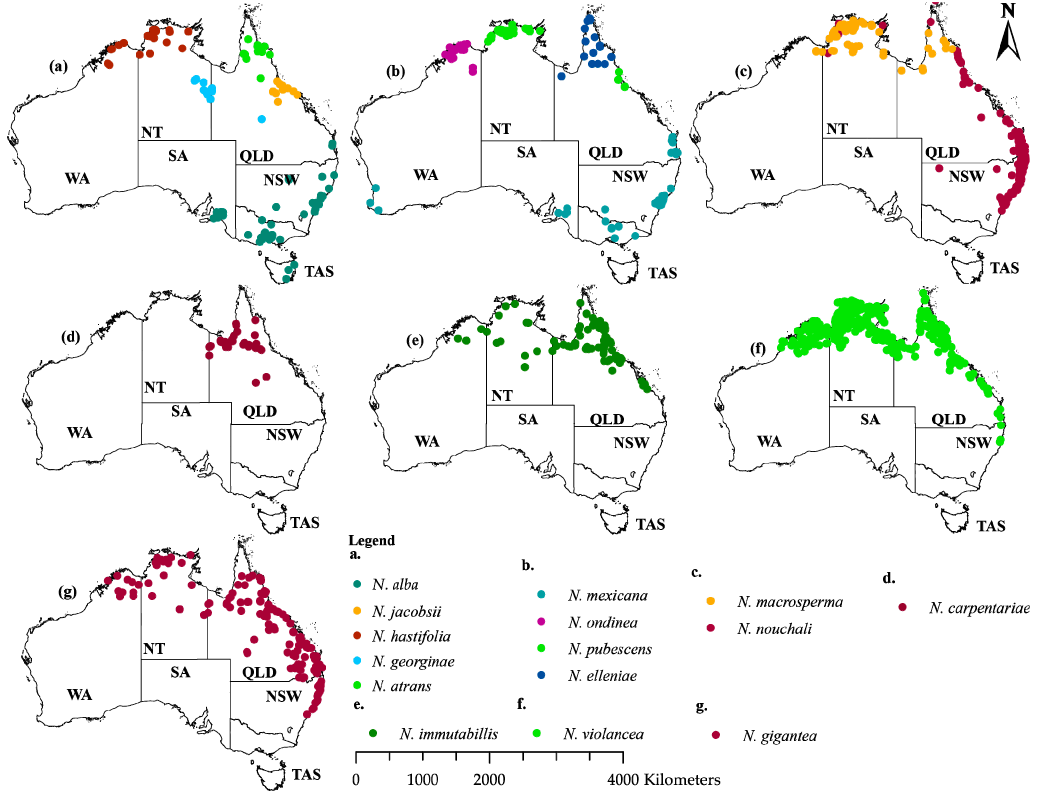
Figure 4. Species occurrence points were used in the habitat suitability modeling of the fourteen Nymphaea species in Australia. The abbreviations represent Western Australia (WA), North Territory (NT), South Australia (SA), Queensland (QLD), New South Wales (NSW), and Tasmania (TAS).